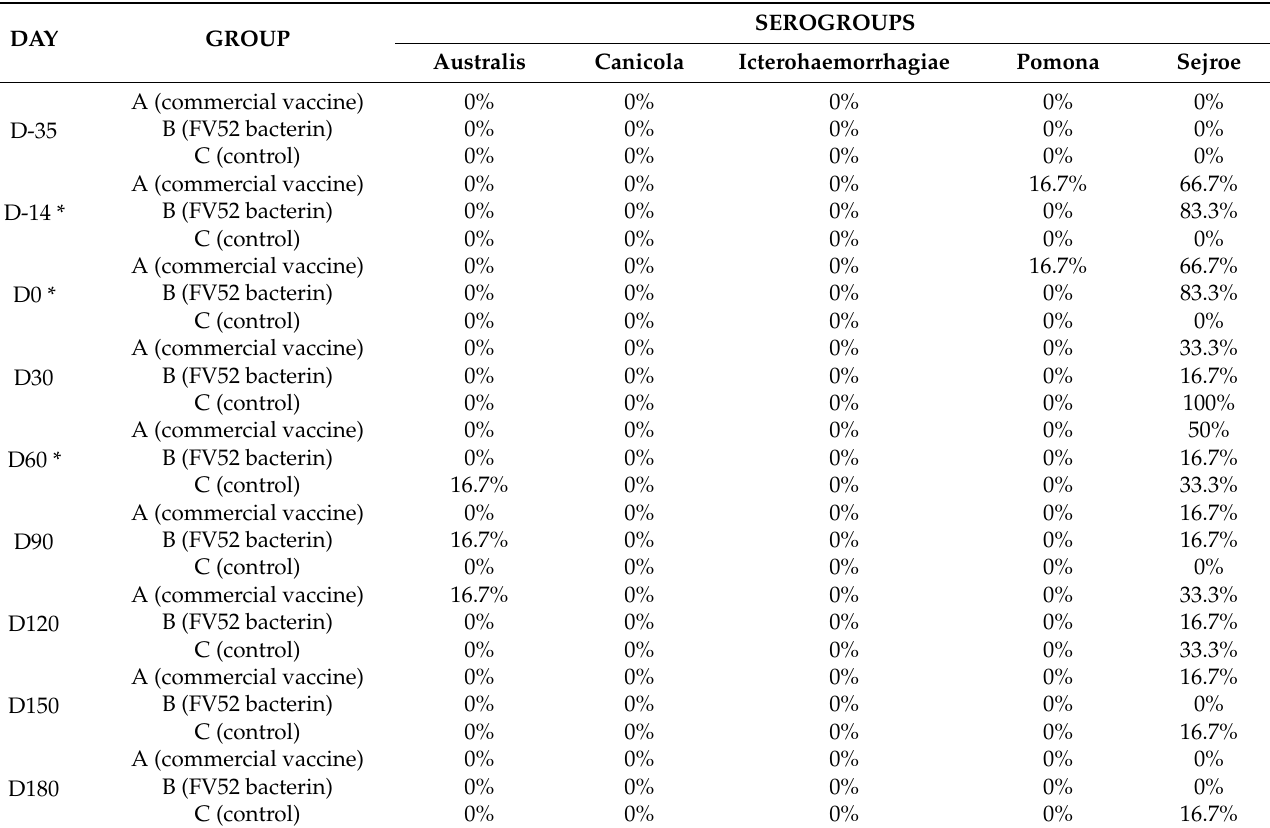
Table 1. Percentage of seroreactivity of studied sheep as measured by MAT against serogroups included in the vaccine and experimental infection between D-35 (first vaccine dose) and D180 post-infection. * p < 0.05 between vaccinated and non-vaccinated